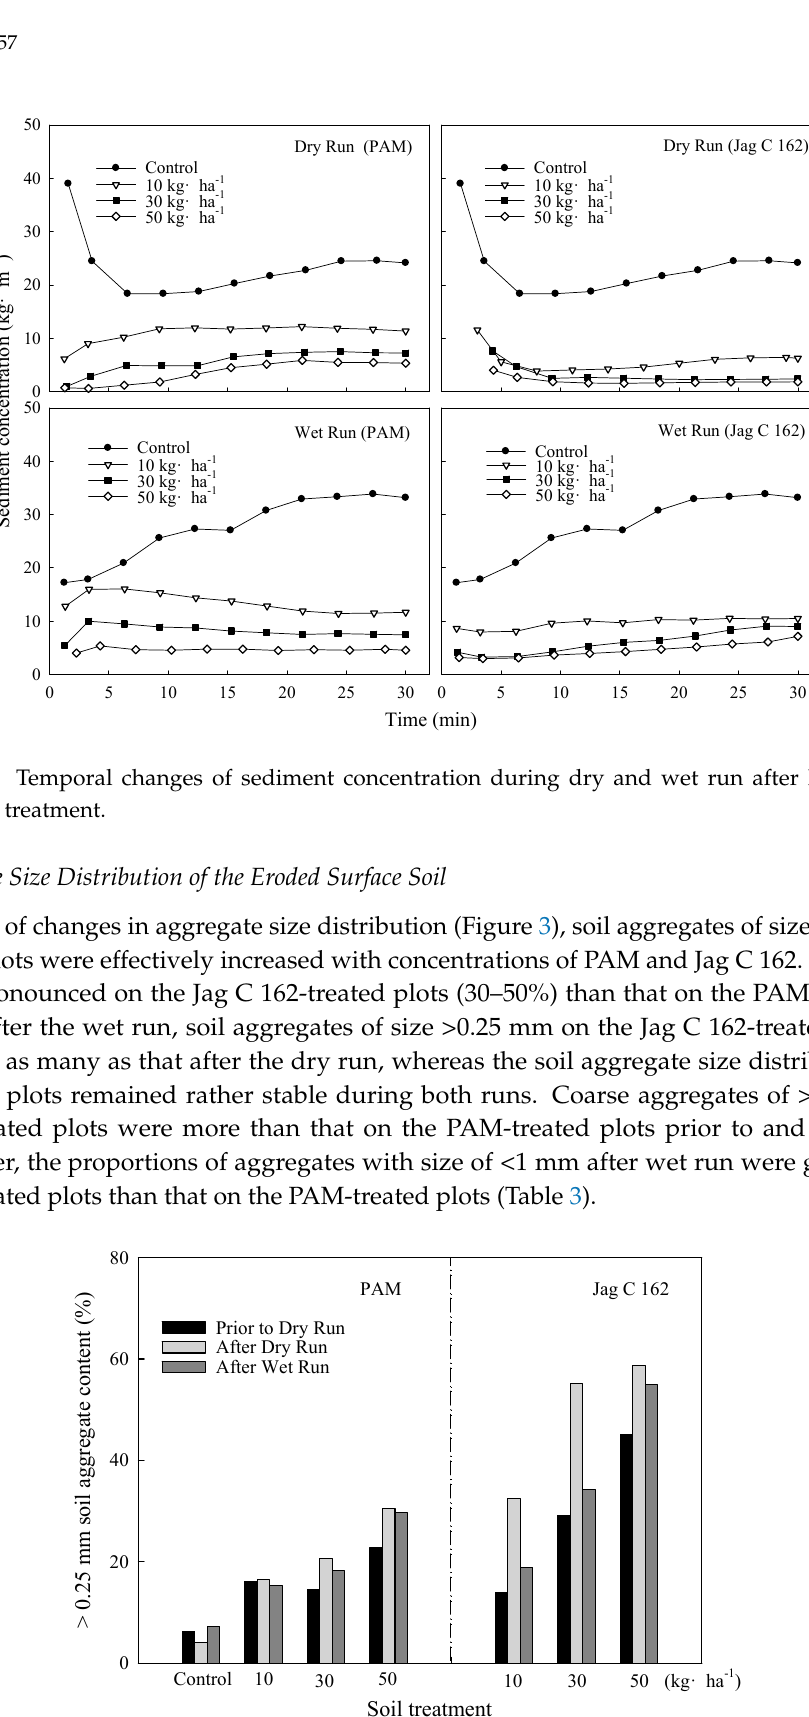
Figure 3. Effects of PAM and Jag C 162 on >0.25 mm soil aggregates.